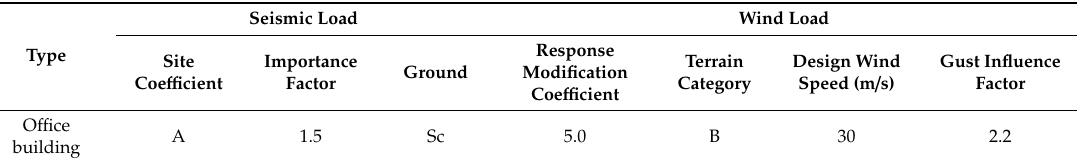
Table 4. Load factors of the